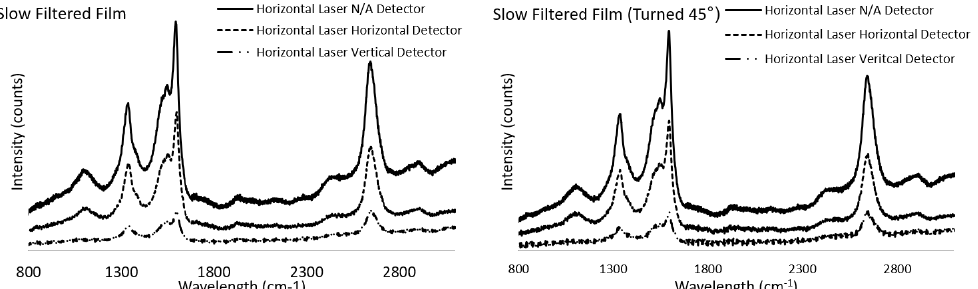
Figure A1. Raman spectra with different detector polarisation for slow-filtered and fast-filtered films. These spectra show the characteristic D (1340 cm −1 ), G (1600 cm −1 ), and G’ (2700 cm −1 ) peaks for SWCNTs [45,46].